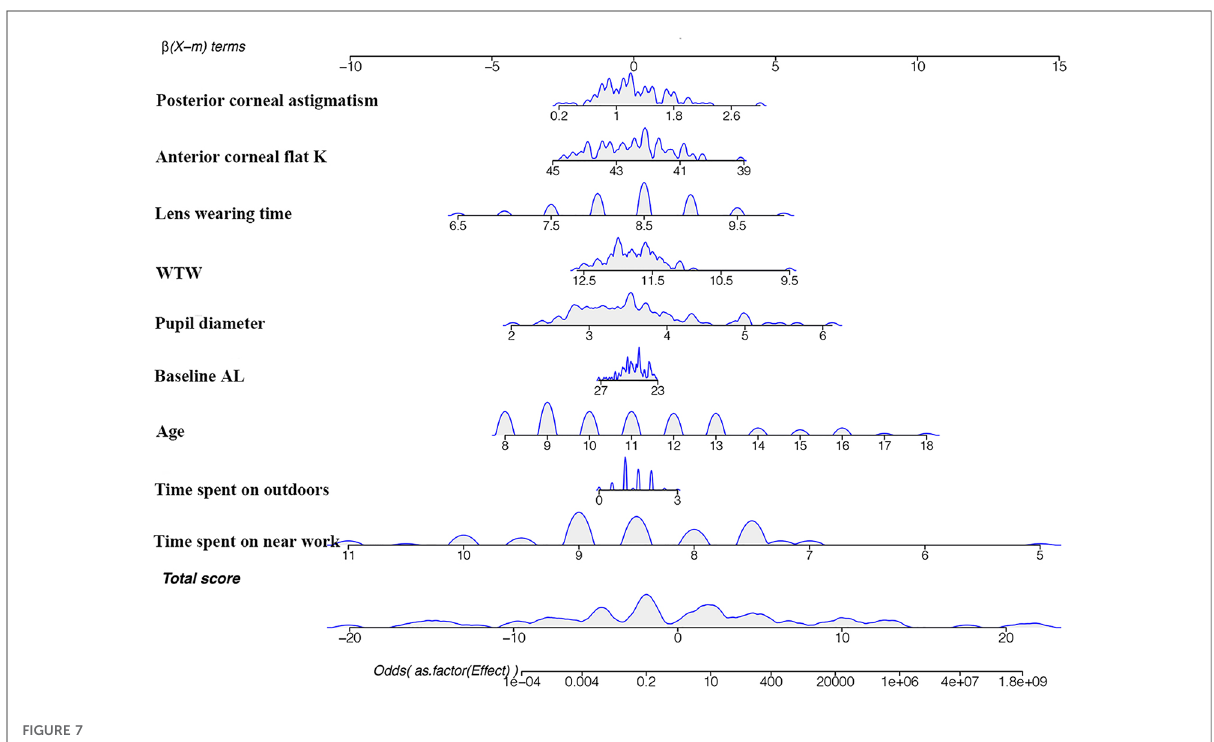
FIGURE 7 Calibration